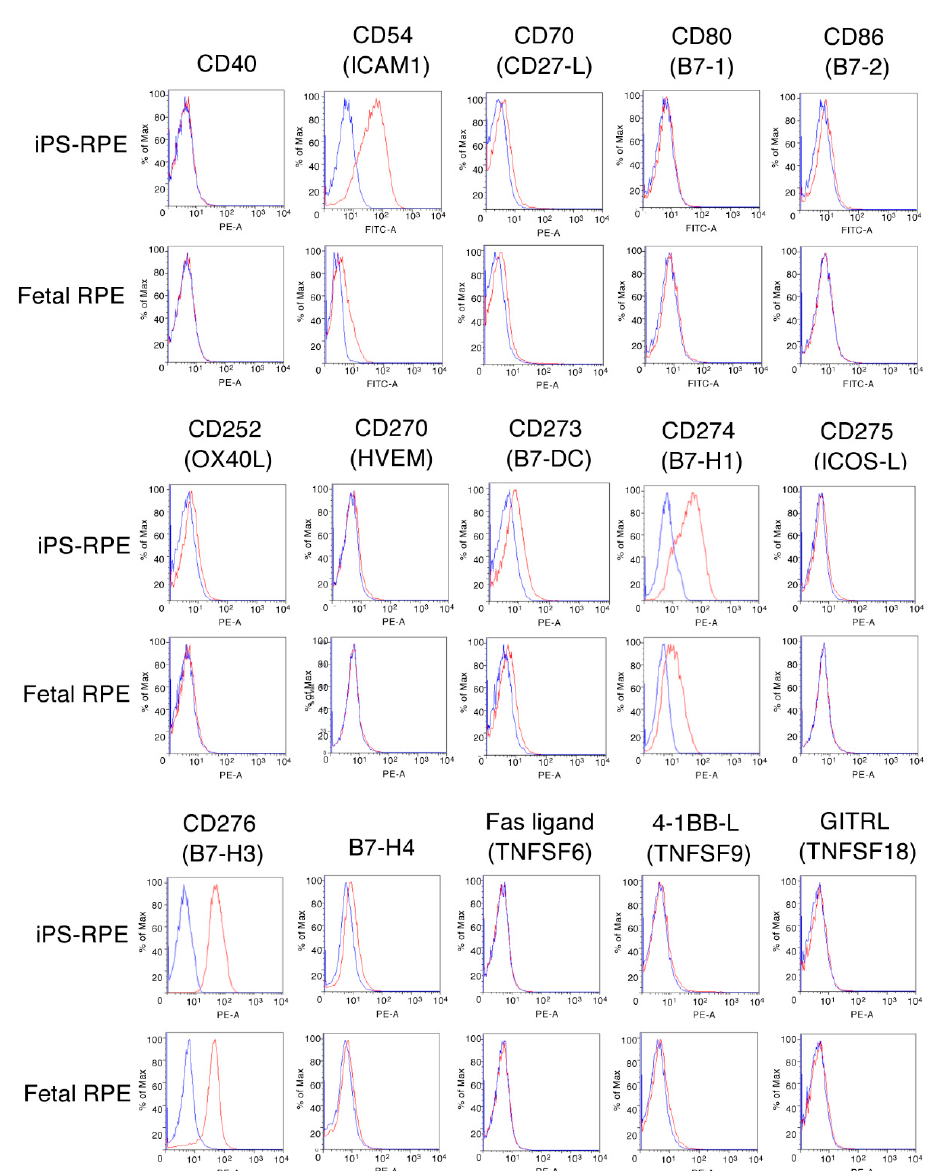
Figure 2. Expression of costimulatory molecules on human iPS cell-derived RPE cells. Human iPS-RPE cells (836B1) or control primary human RPE cells (fetal RPE cells) were stained with antihuman CD40, CD54 (ICAM1), CD70 (CD27 ligand), CD80 (B7-1), CD86 (B7-2), CD252 (OX40L), CD270 (HVEM), CD273 (PD-L2 / B7-DC), CD274 (PD-L1 / B7-H1), CD275 (ICOS-L / B7-H2), CD276 (B7-H3), B7-H4, Fas ligand (CD95 ligand / TNFSF6), 4-1BBL (CD137 ligand / TNFSF9), and GITRL (TNFSF18)